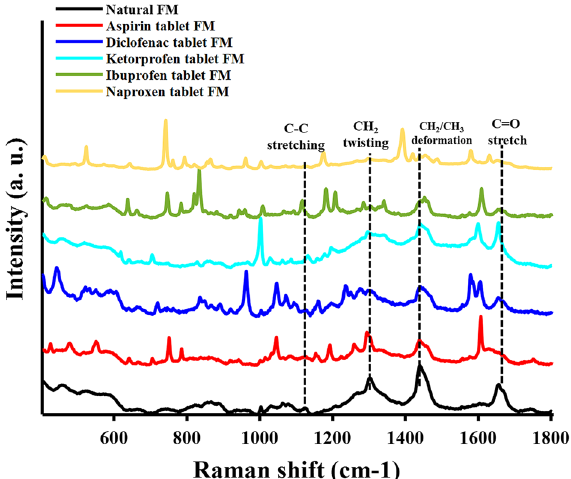
Figure 1. The average Raman spectra of natural fingermark and fingermarks contaminated with aspirin, diclofenac, ketoprofen, ibuprofen or naproxen tablets. The experimental spectra were preprocessed by baseline correction and